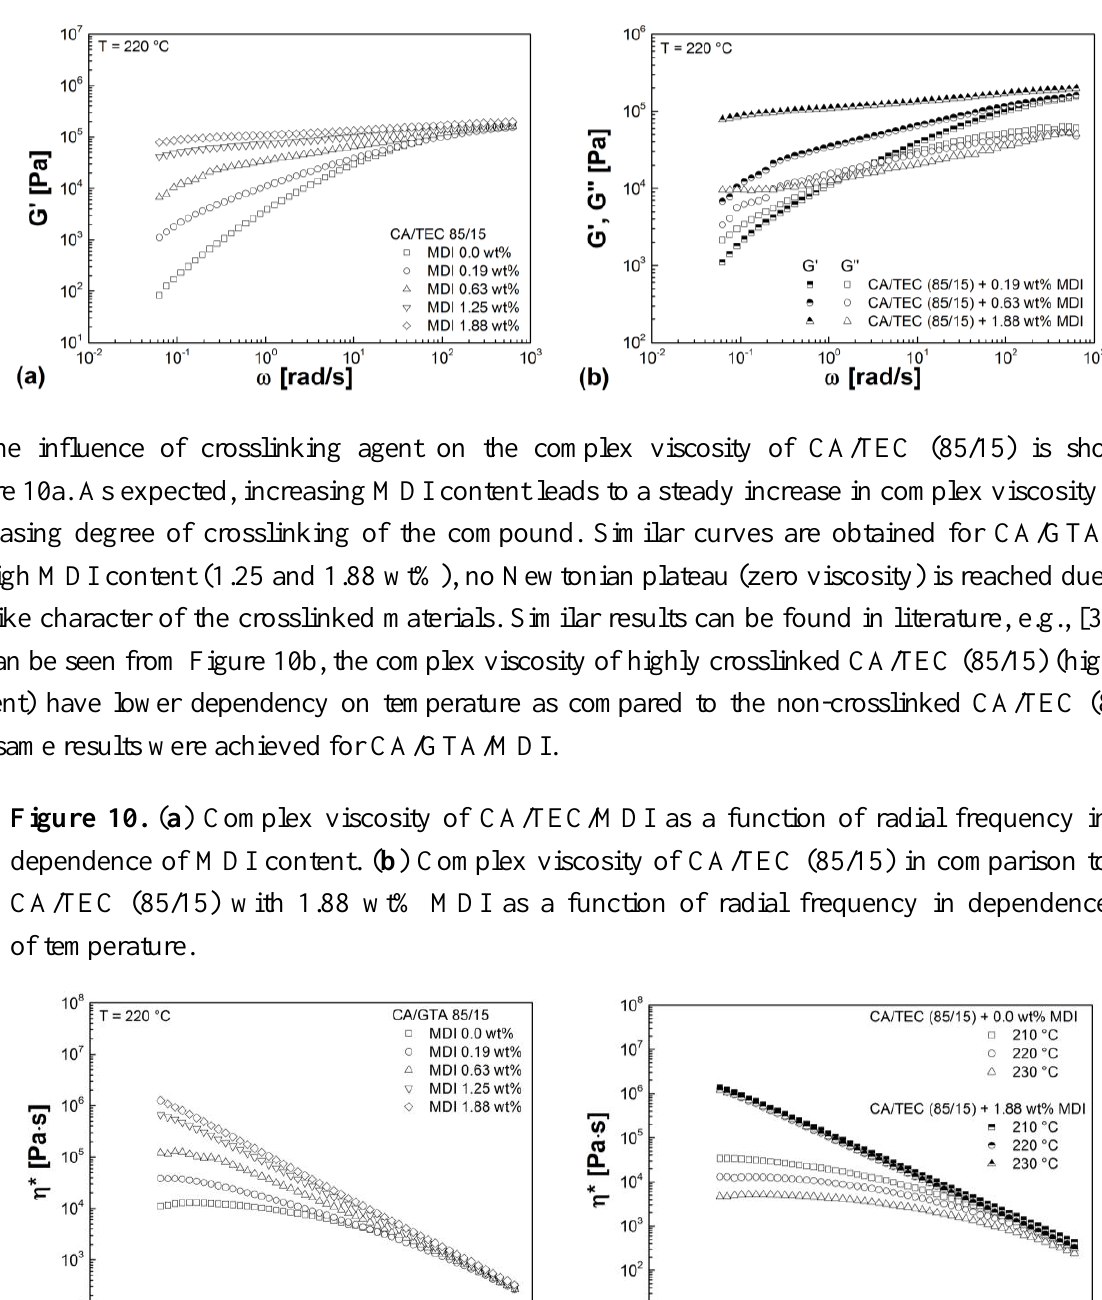
Figure 9. ( a ) Storage modulus of CA/TEC/MDI as a function of radial frequency in dependence of MDI content. ( b ) Storage modulus and loss modulus as a function of radial frequency for CA/TEC (85/15) with 0.19 wt%, 0.63 wt%, and 1.88 wt% MDI.